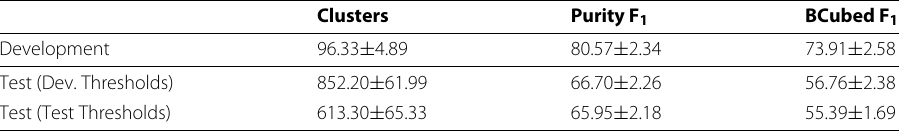
Table 10 Semantic frame slot induction